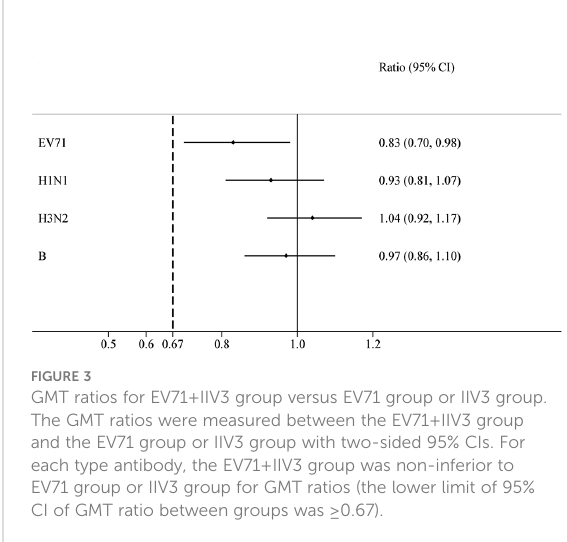
FIGURE 3 GMT ratios for EV71+IIV3 group versus EV71 group or IIV3 group. The GMT ratios were measured between the EV71+IIV3 group and the EV71 group or IIV3 group with two-sided 95% CIs. For each type antibody, the EV71+IIV3 group was non-inferior to EV71 group or IIV3 group for GMT ratios (the lower limit of 95% CI of GMT ratio between groups was ≥